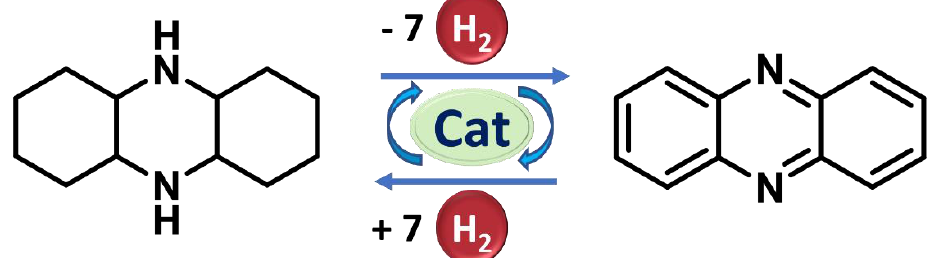
Figure 10. The schematic illustration of perhydro-phenazine/phenazine LOHC system.